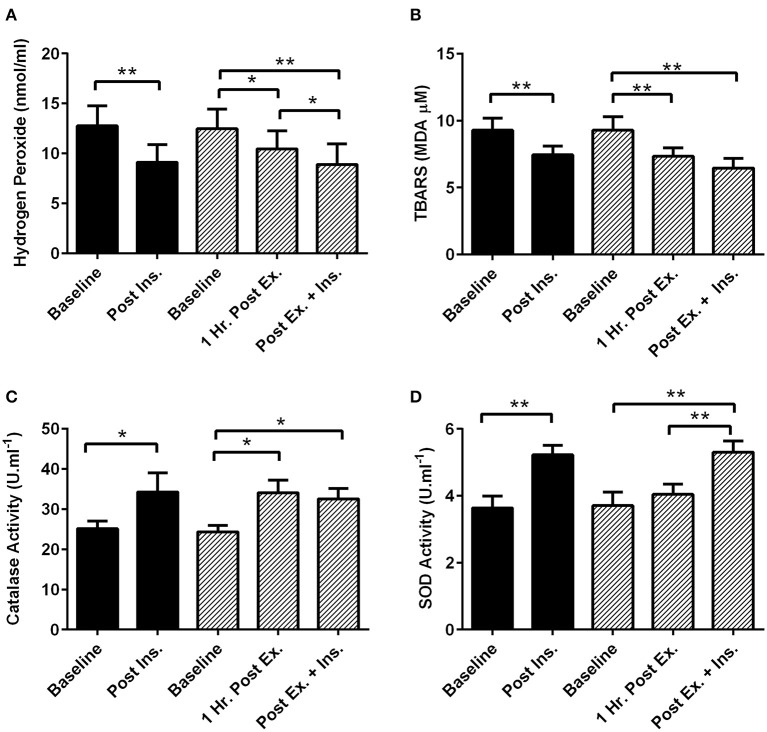
Exercise, insulin stimulation, and plasma redox status. Oxidative stress and antioxidant enzymatic activity biomarkers in plasma 1 h after exercise (prior to insulin stimulation), and pre and post insulin stimulation at rest and 3 h after exercise (n = 11). (A) Hydrogen Peroxide; (B) Thiobarbituric acid reactive substances (TBARS); (C) Catalase activity; (D) Superoxide dismutase activity (SOD). *p < 0.05 and **p < 0.01 are significantly different. Black bars = rest trial. Diagonal line bars = exercise trial. Ex. = High-intensity interval exercise. Ins. = insulin stimulation via the hyperinsulinaemic-euglycaemic clamp.